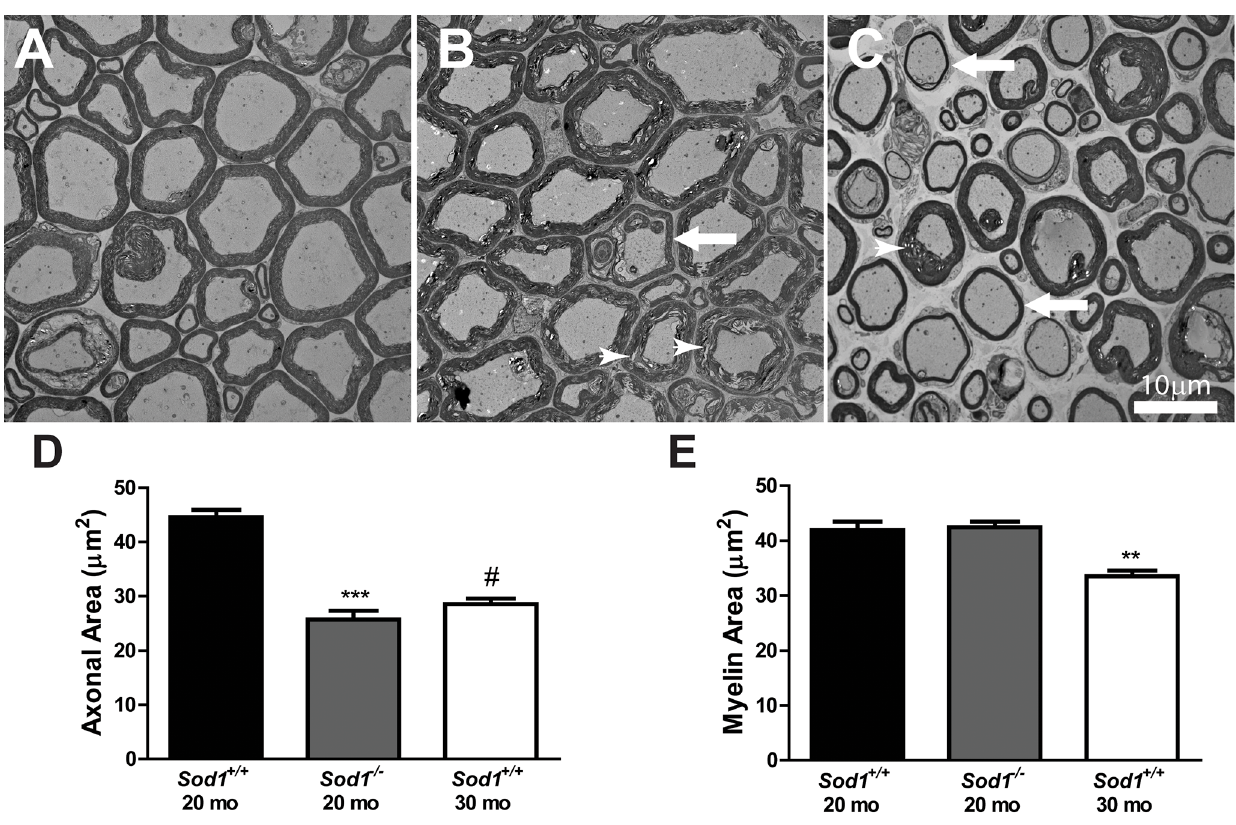
Figure 6. Structural deficits in the axons and myelin of motor neurons in the Sod1 mice. Transmission electron microscopy (TEM) of the ventral roots from A) Sod1 + / + mice at 20 mo, B) Sod1 2 / 2 mice at 20 mo, and C) Sod1 + / + mice at 30 mo revealed thinning myelin (arrow) and delaminating myelin (arrow head). Scale bar=10 m m. The area of D) axons and E) myelin in the ventral root was measured by light microscopy in the Sod1 + / + mice at 20 and 30 mo (n=9, 3, and 5, respectively) and Sod1 2 / 2 mice at 20 mo (n=19, and 10). **p , 0.001, ***p , 0.0001, and # p , 0.0001 compared to Sod1 + / + mice at 20 mo.